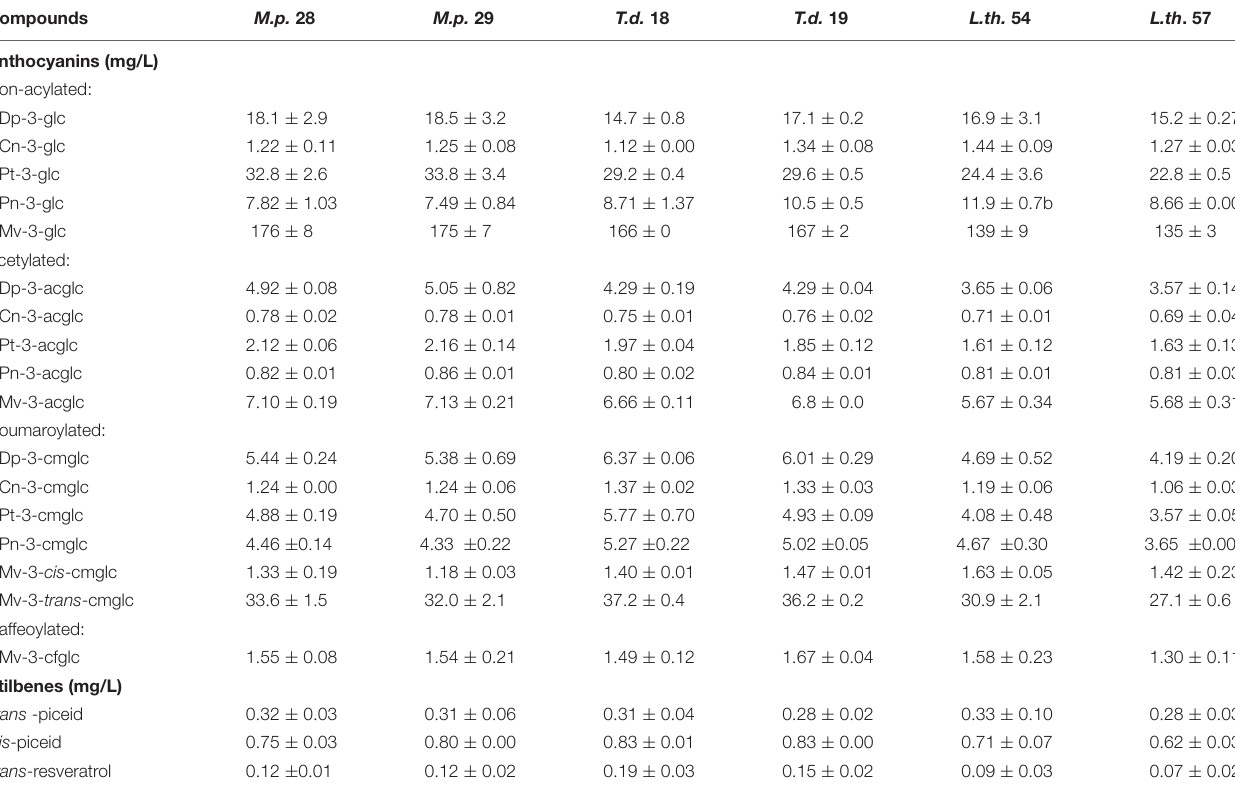
TABLE 2 | Average anthocyans and stilbenes content ( n = 2) in wines sequentially fermented with two clones of the yeast species M.p : Metschnikowia pulcherrima , T.d : Torulaspora delbrueckii, and L.th : Lachancea thermotolerans.